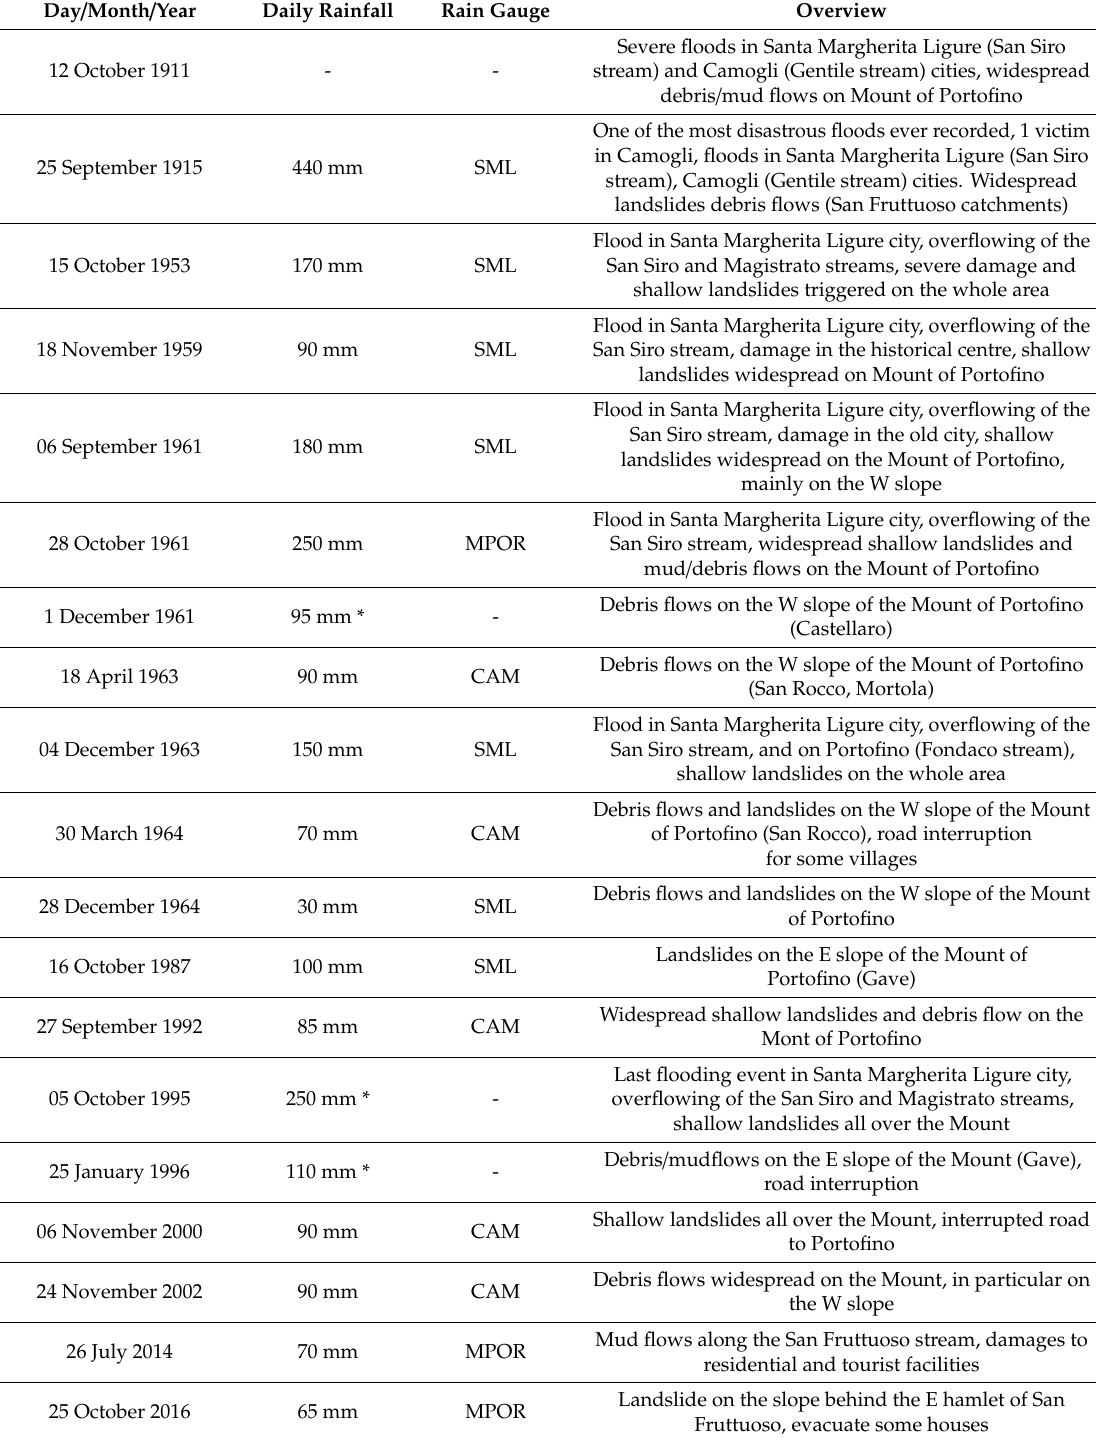
Table 2. The main flood, debris flow and landslide events from 1900 to the present day (modified from Brandolini et al. [48], Faccini et al. [55], Turconi et al. [57] in press). Rain gauge: Santa Margherita Ligure (SML), Camogli (CAM), MPOR (Monte di